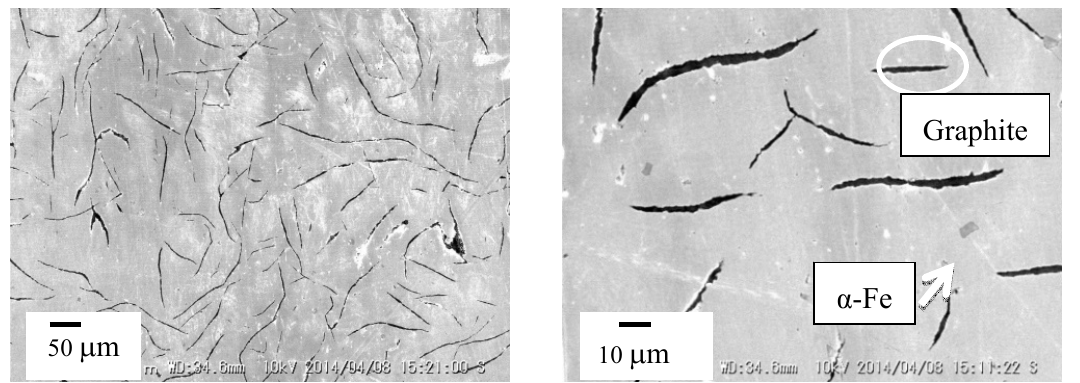
Figure 2. Cross-sectional views of cast iron bulk.